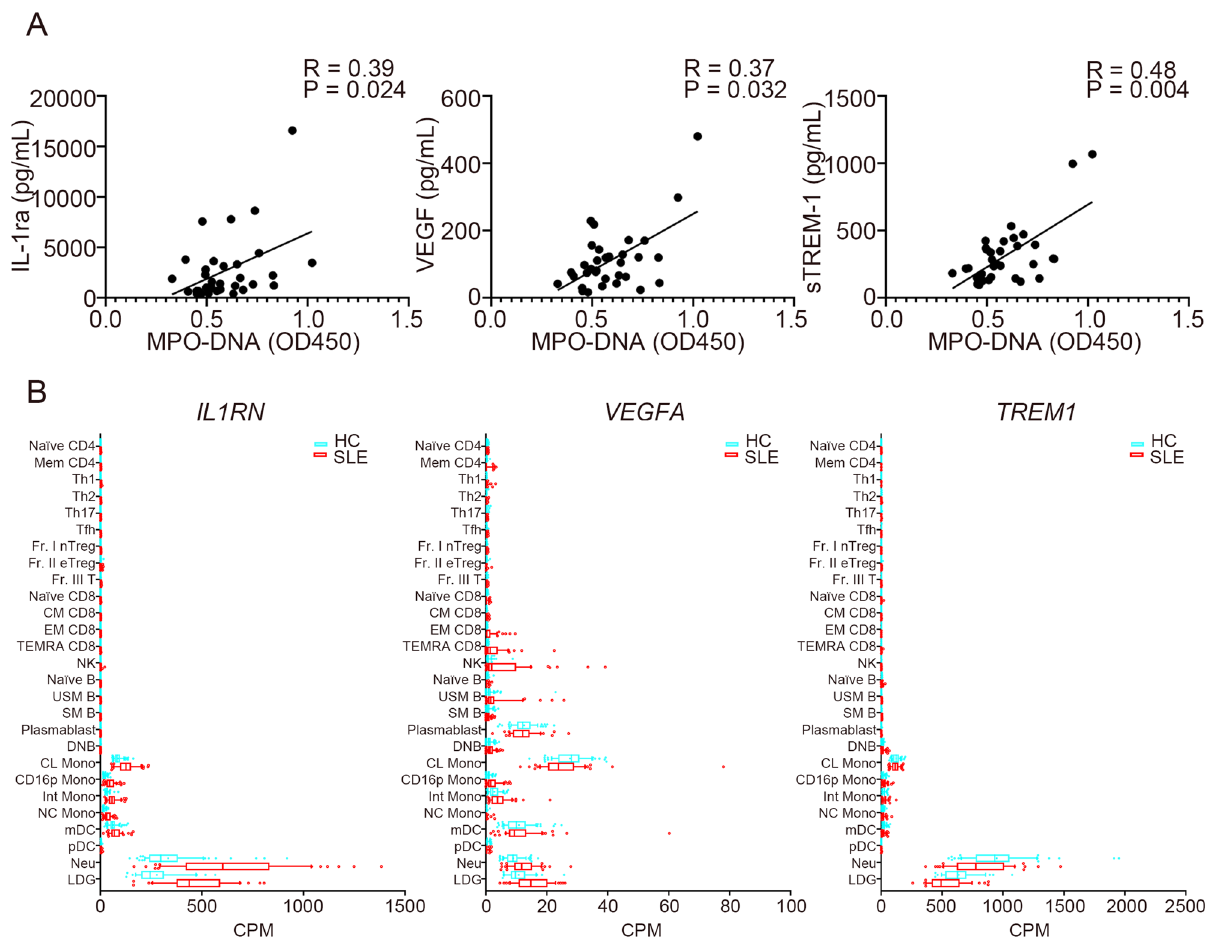
Figure 3. Serum MPO-DNA complex levels and correlations with cytokine and functional protein levels. ( A ) Correlations between serum MPO-DNA complex levels and serum IL-1RA, VEGF, and sTREM1 levels were analyzed (n = 33 for each; Spearman’s rank correlation coefficients). ( B ) mRNA expression of IL1RN , VEGF , and TREM1 in HCs and SLE patients from the ImmuNexUT database. CD16p Mono: CD16-positive monocytes;